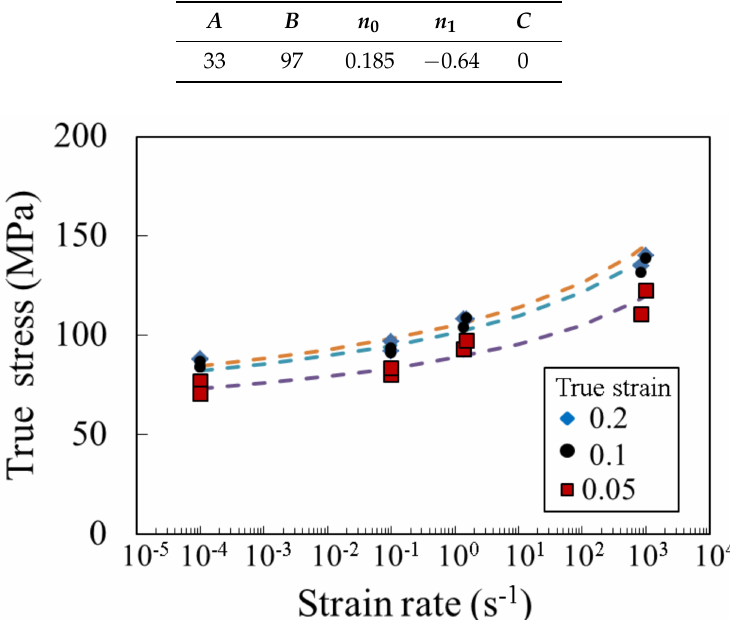
Figure 6. Stress and strain rate relationship of 1070 aluminum. The curves indicated by broken line were obtained from Equation